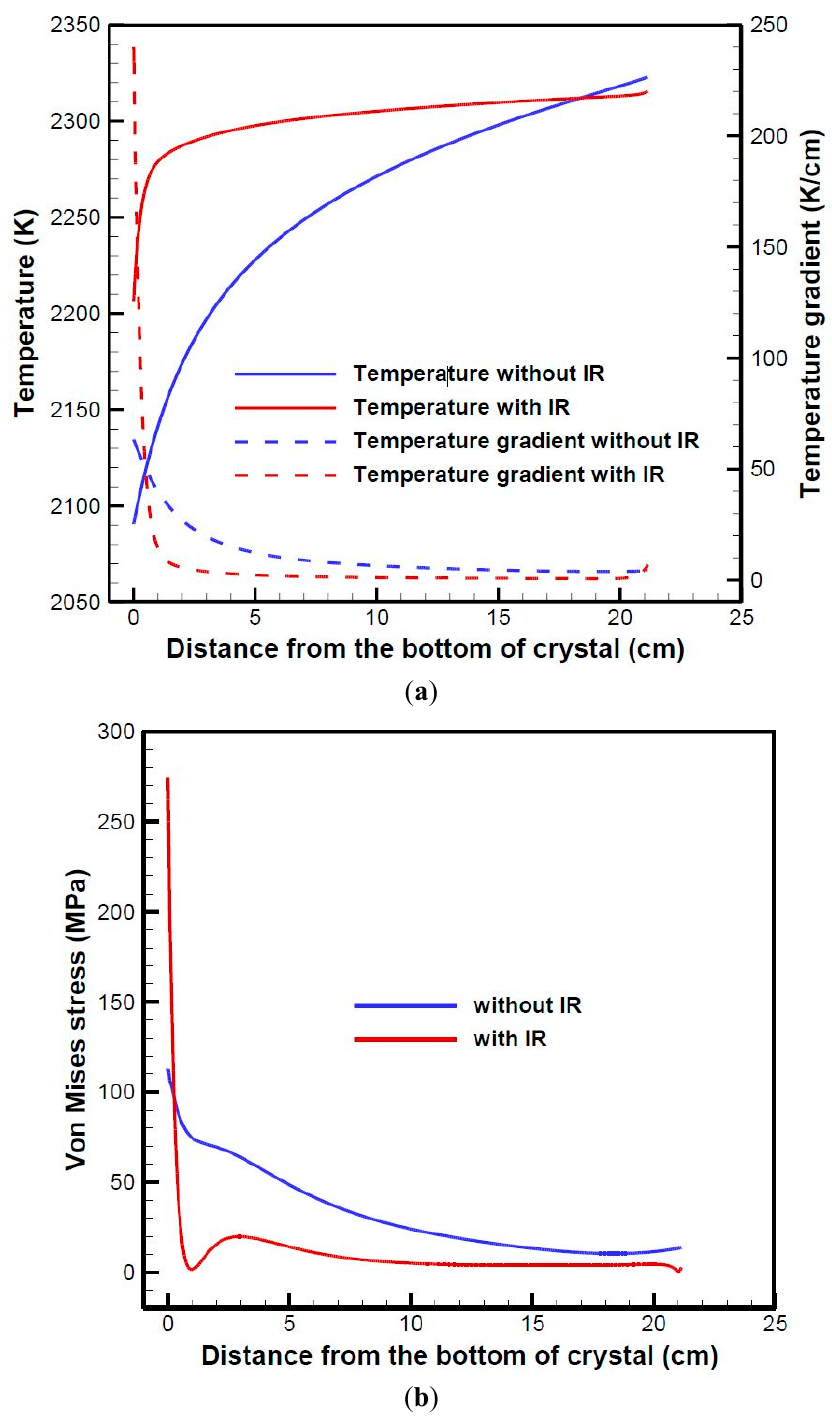
Figure 4. Temperature, temperature gradient ( a ); and thermal stress ( b ) along the centerline of the crystal in Figure